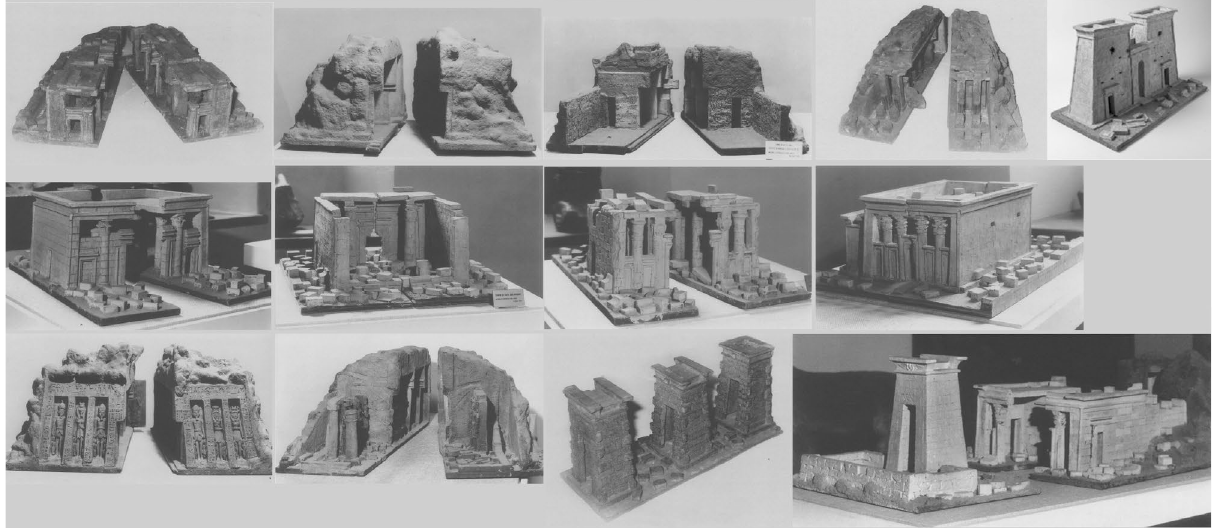
Figure 3. The collection of ‘expedition models of Egyptian